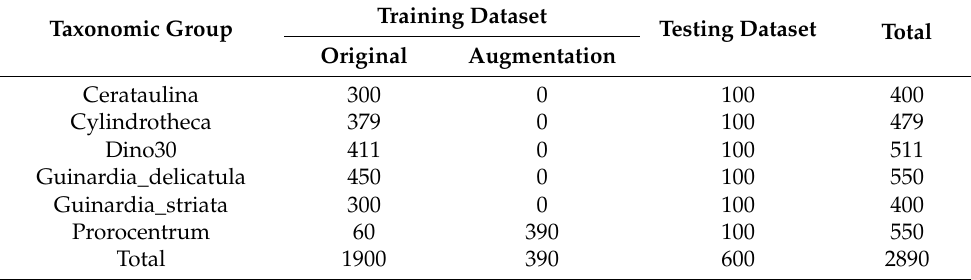
Table 3. Components of the dataset with data augmentation for two rare taxa.